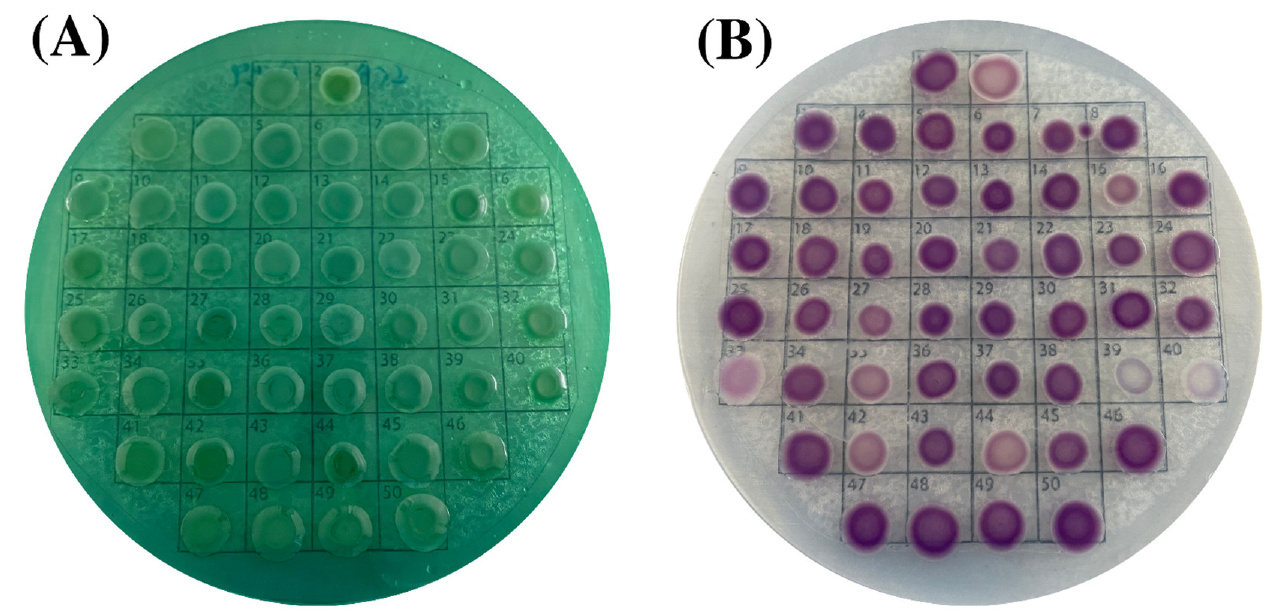
Figure 2. Colony morphology of fifty V. parahaemolyticus isolates on thiosulphate citrate bile salts sucrose agar plate ( A ) and CHROMagar TM Vibrio agar plate ( B ).